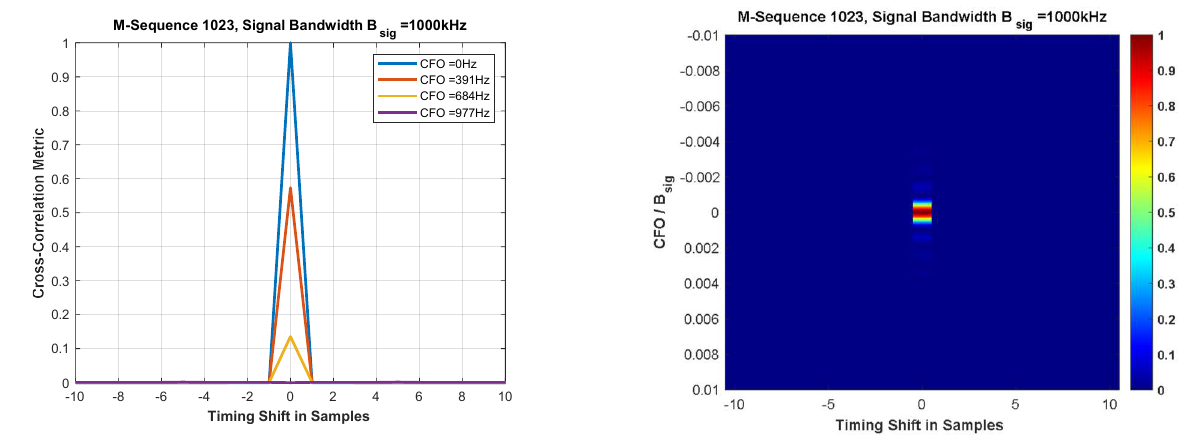
Figure 7. Cross-correlation performance of bipolar M-sequences used for time–frequency synchro- nization.